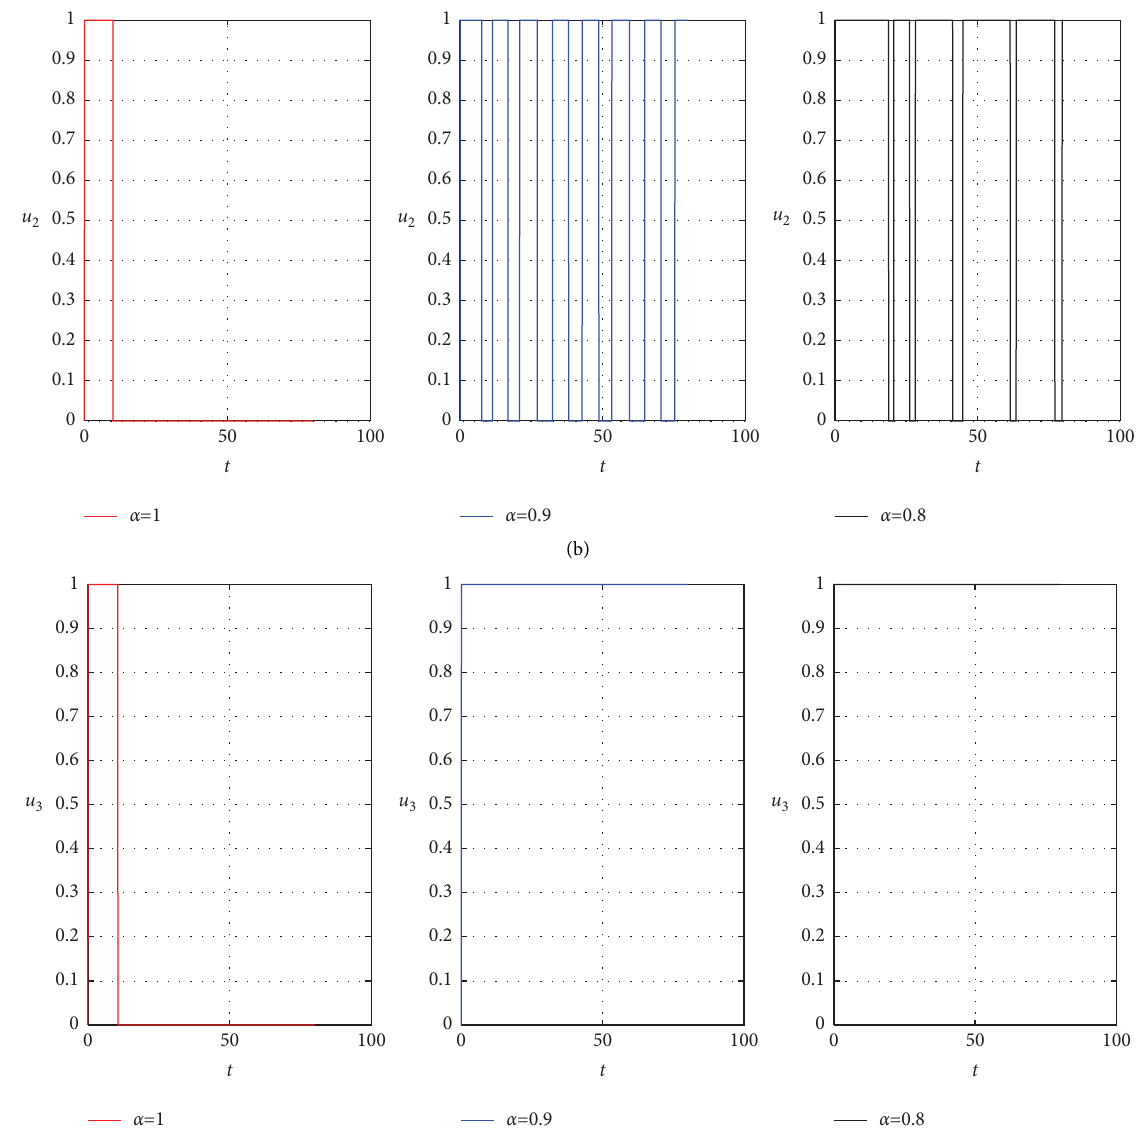
, u , and u , where a � 0 . 1 , b � 0 . 1 , c � 0 . 1 , e � 0 . 3 , f � 0 . 2 , h � 0 . 3 , i � 0 . 2 , C 1 2 3 � 0 . 02 , and A � 0 . 03 2 3